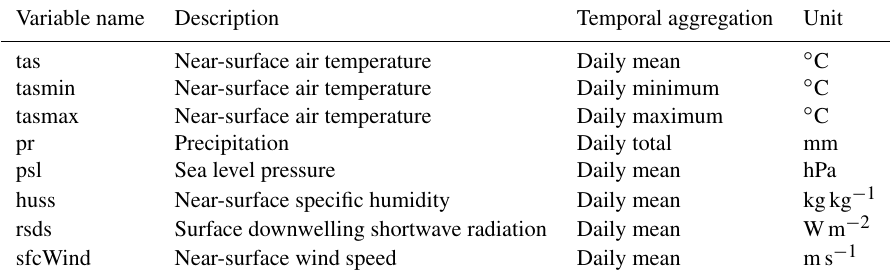
Table 1. Meteorological variables provided in dataset release 1 (depending on user demand, this list can be